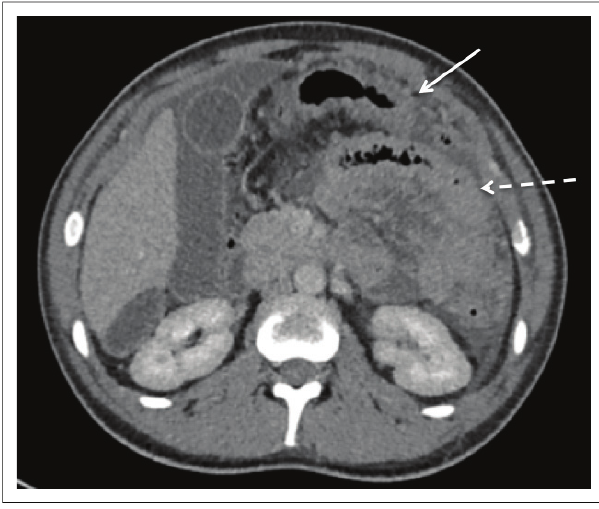
FIGURE 7: Axial reconstruction of portovenous phase–enhanced CT in a 23-year- old male patient with a CD4 count of 70 cells/ μ L. The image demonstrates diffuse serosal thickening of the jejunum (dashed arrow), ascites and peritoneal nodularity (solid arrow). Histological diagnosis of TB was made following ascitic tap.